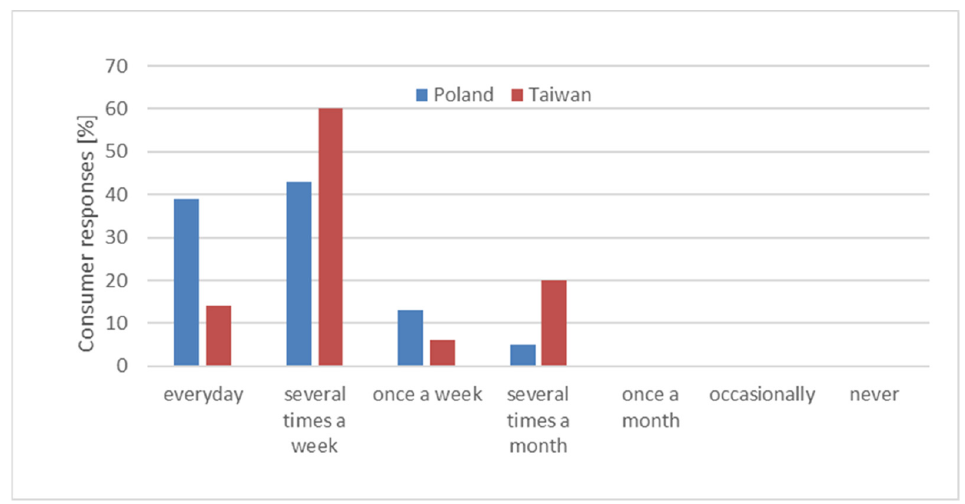
Figure 1. Frequency of dairy products consumption by Polish and Taiwanese consumers.